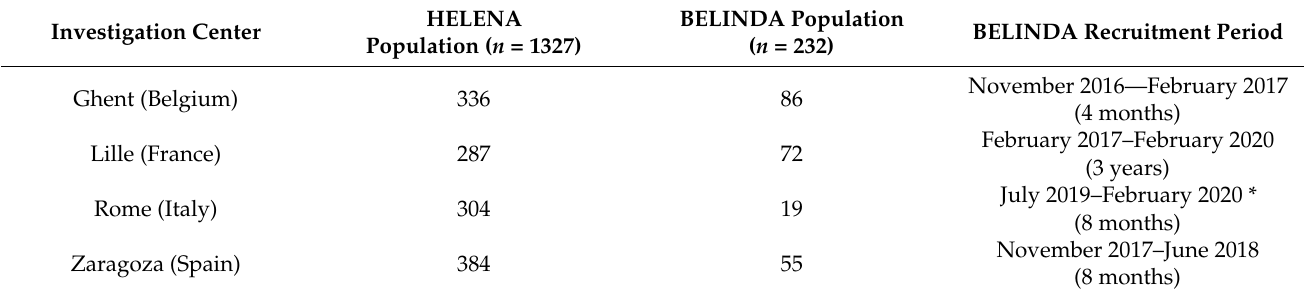
Table 5. BELINDA population detailed by investigation center.